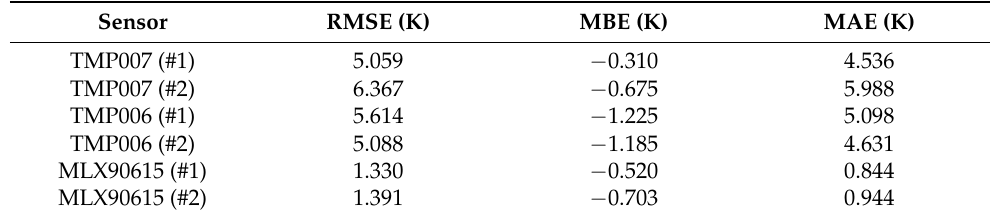
Table A5. Root mean square error (RMSE), mean bias error (MBE), and mean absolute error (MAE) for the values of the tested infrared temperature